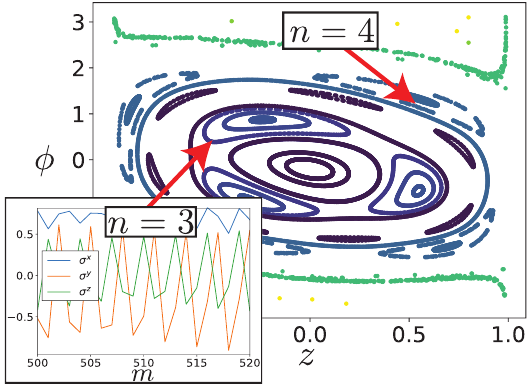
Figure 5: Stroboscopic aliasing subharmonic response in the presence of collective spin emission. Depending on initial conditions an n = 4 or an n = 3 subharmonic oscillation can occur. The inset also shows the n = 3 subharmonic response for an initial state with z = 0.5 and φ = − 0.5. In this figure α = 0, and we have used a mean field approximation which assumes the thermodynamic limit: N → ∞